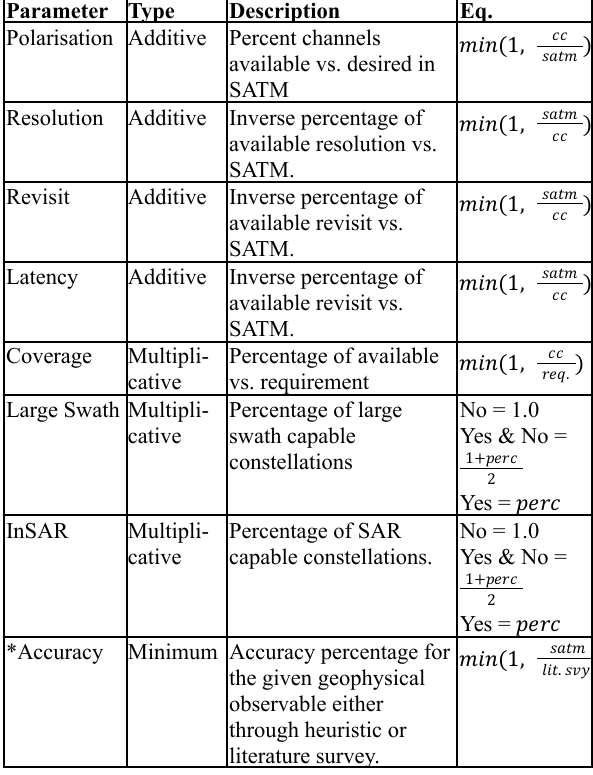
Table 1 . Parameters used in the